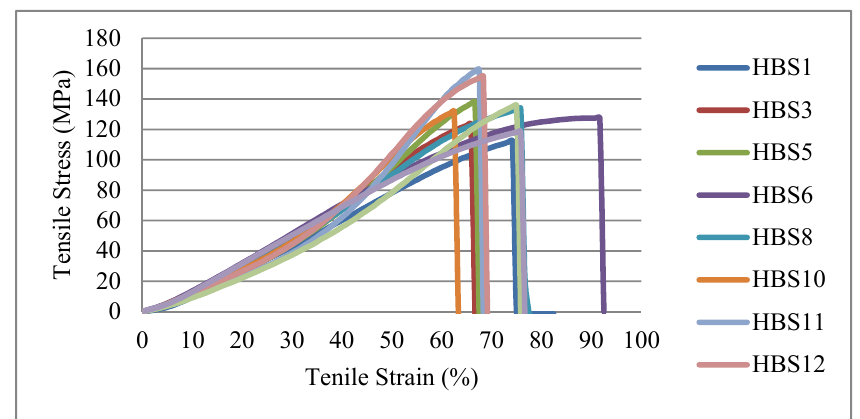
Figure 4. Stress–strain curves of braided sutures.